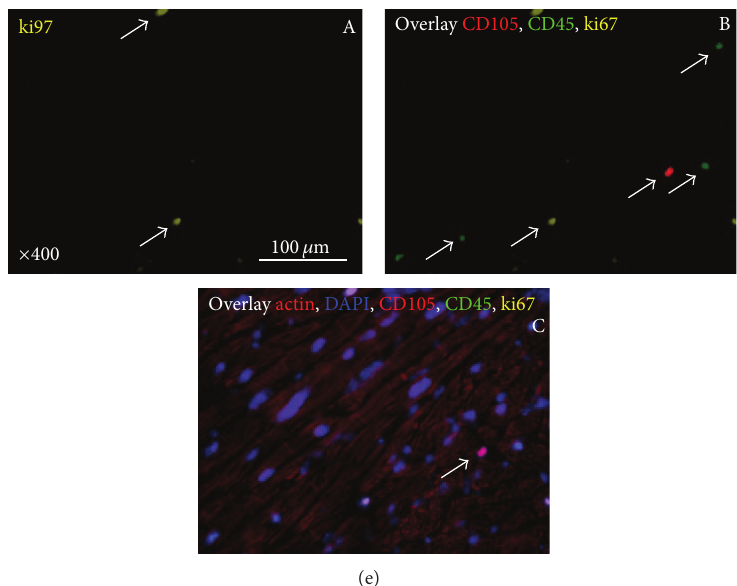
Figure 3: Immunostaining and quantification of cardiac MSC related to cardiac inflammation and expression of SDF-1 𝛼 mRNA. (a) Representative image of immunofluorescence of MSC in EMB. Serial sections were stained with (A) an overlay of 𝛼 -sarcomeric actin (red), nuclear counterstained (DAPI, blue), anti-CD105 and anti-CD90 (red, and B), and anti-CD45 (green, and C) as a lymphocytes marker (the arrow image (A) highlights the MSC). (b) Quantitative analysis of CD45 − CD34 − CD105 + CD90 + -MSC in EMB of patients without ( 𝑛 = 6 ) and with ( 𝑛 = 23 ) cardiac inflammation, as defined by the number of LFA-positive cells (box plots are given as median and IQR; whiskers represent 95% CI). (c) Quantitative analysis of CD45 − CD34 − CD105 + CD90 + -MSC in EMB after dichotomisation with respect to SDF-1 𝛼 mRNA expression in their EMB (cut-off: median, box plots are given for median and IQR; whiskers represent 95% CI). (d) Correlation between the transcardiac gradient of circulating MSC and MSC in EMB. (e) Representative image of immunofluorescence of MSC and proliferation in EMB. The same serial sections as indicated above (3(a)) were stained with (A) anti-Ki67 (yellow) for proliferation, (B) overlay of CD105 (red), anti-CD45 (green), and Ki67 (yellow), and (C) overlay of 𝛼 -sarcomeric actin (red), nuclei (DAPI, blue), CD105 (red), anti- CD45 (green), and Ki67